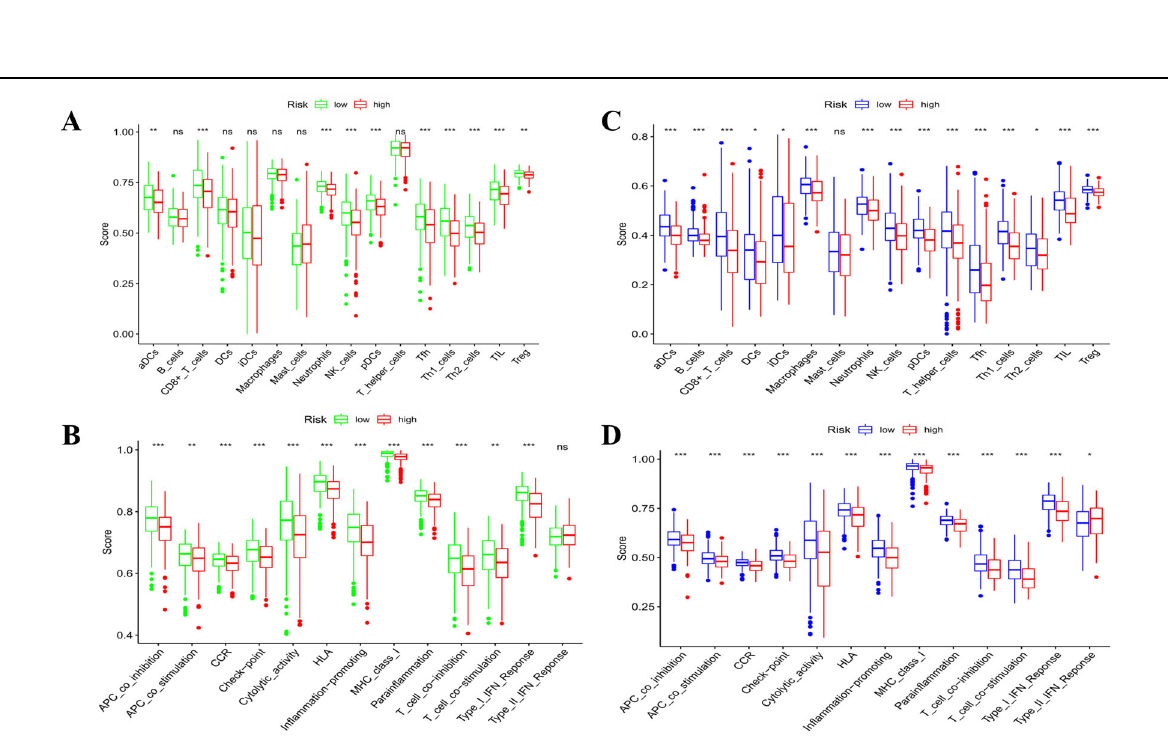
Fig. 7 Comparison of the ssGSEA scores for immune cells and immune pathways. A , B Comparison of the enrichment scores of 16 types of immune cells and 13 immune-related pathways between low- (green box) and high-risk (red box) group in the TCGA cohort. C , D Comparison of the tumour immunity between low- (blue box) and high-risk (red box) group in the GEO cohort. P values were showed as: ns not signi fi cant; * P < 0.05; ** P < 0.01; *** P <